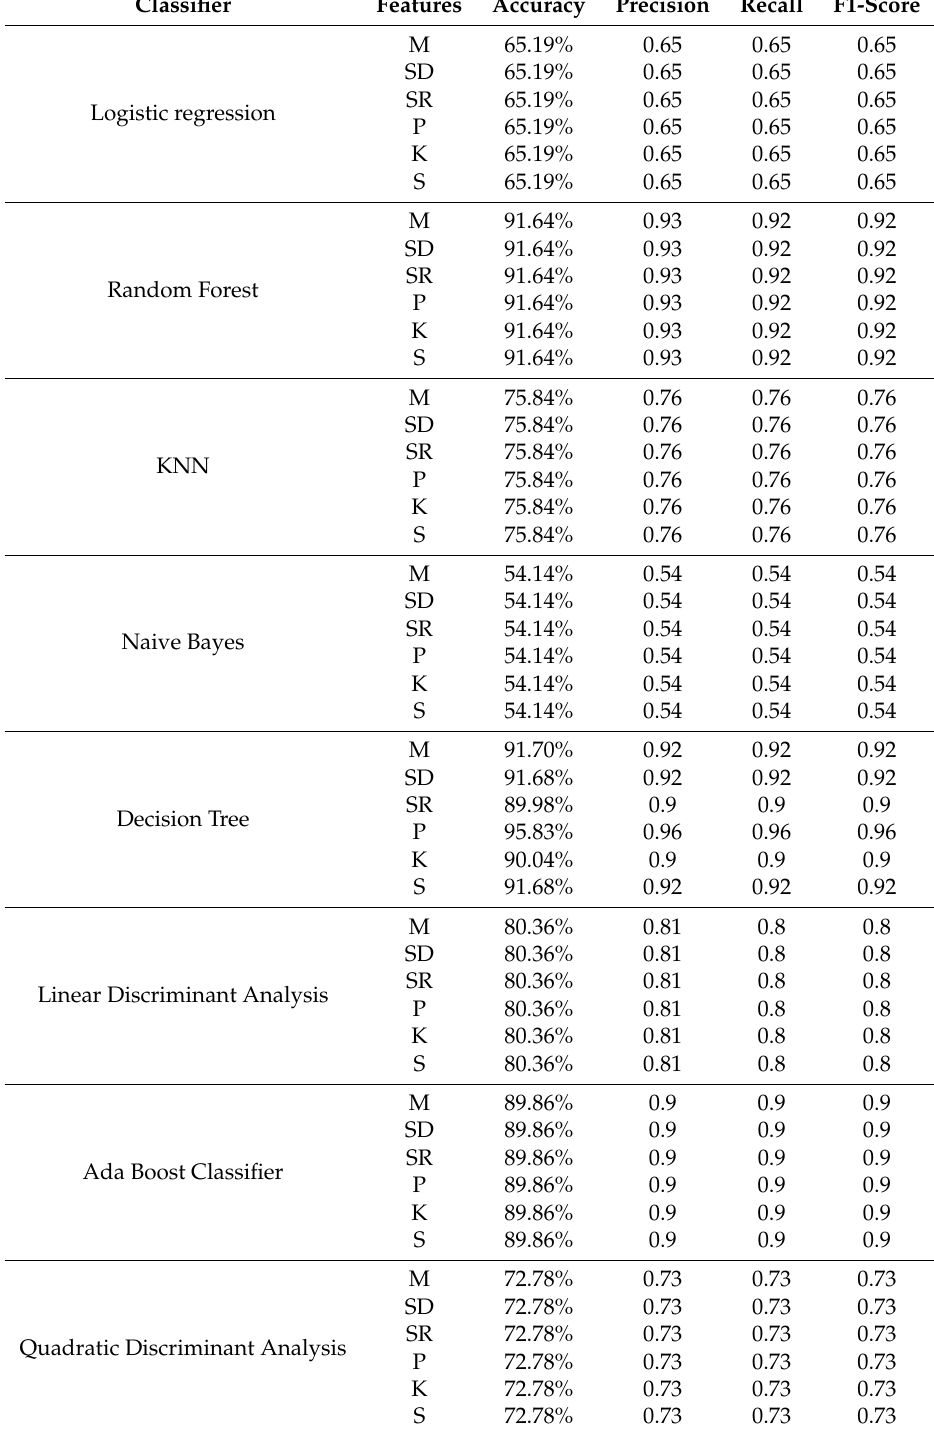
Table 3. Summary of ML results for individual features.